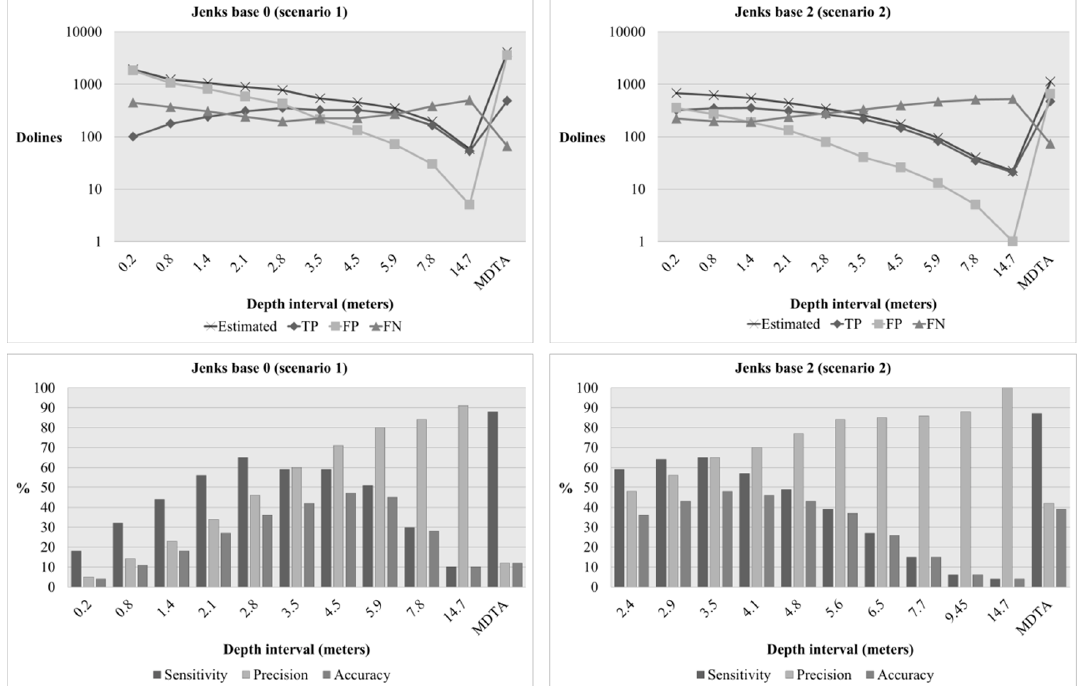
Figure 5. Binary analysis of two Jenks classification scenarios from the overlap of estimated dolines against real dolines mapped by high-resolution imagery. TP is the number of estimated dolines matching those from imagery analysis (true positives); FP are those estimated without match (false positives) and FN are dolines from imagery which are not overlapped by estimated ones (false negatives).